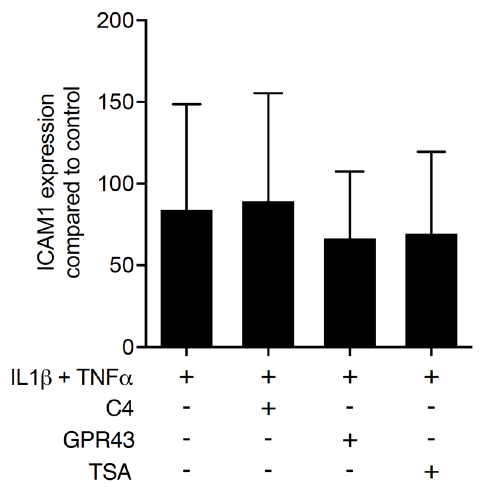
Figure 6. Butyrate cannot reverse expression levels of ICAM-1 in HSC-2 cells. HSC-2 cells were exposed to 10 ng/mL IL1 β and TNF α for 1 h before 10 mM of butyrate (C4) was added for another 3 h. In this setting, butyrate FFAR2/GPR43 agonist and trichostatin A (TSA) failed to modulate the ICAM-1 expression in HSC-2 cells. (+), indicates presence; (-), indicates absence. Data represent the mean change of ICAM-1 expression ± standard deviation. n = 3. Statistical analysis was based on t - test.